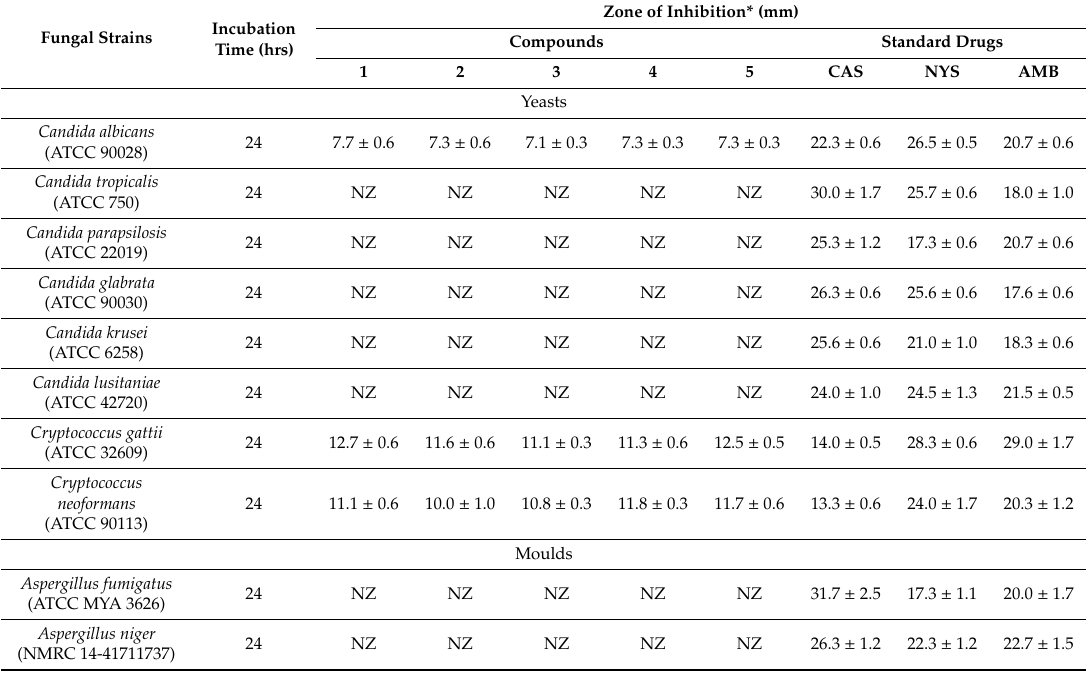
Table 1. Antifungal activity of compounds 1 – 5 against a range of fungal species as determined by the disk diffusion method.